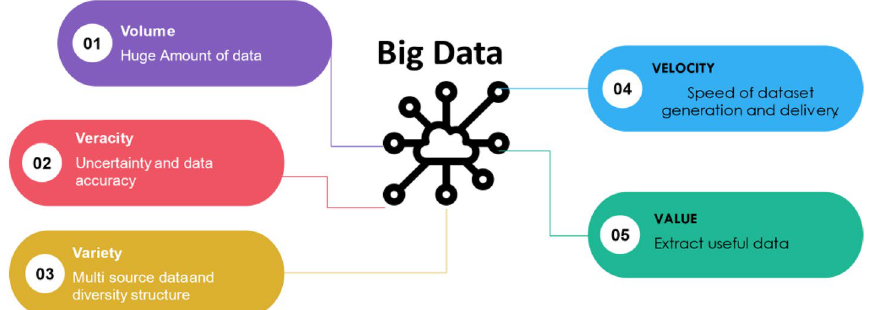
Fig. 1 The 5 main dimensions of big data after Fortune